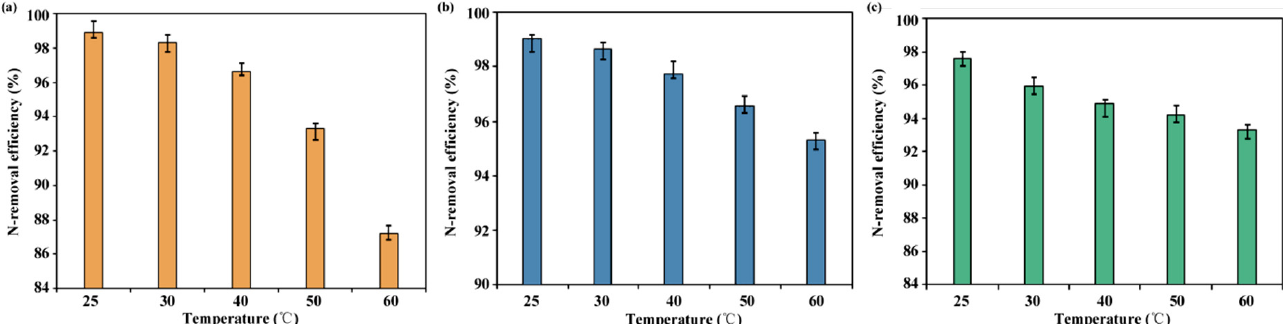
Figure 5. N-removal efficiency of the best IL with different mass ratio of IL to oil for ( a ) pyridine, ( b ) quinoline, ( c ) aniline.